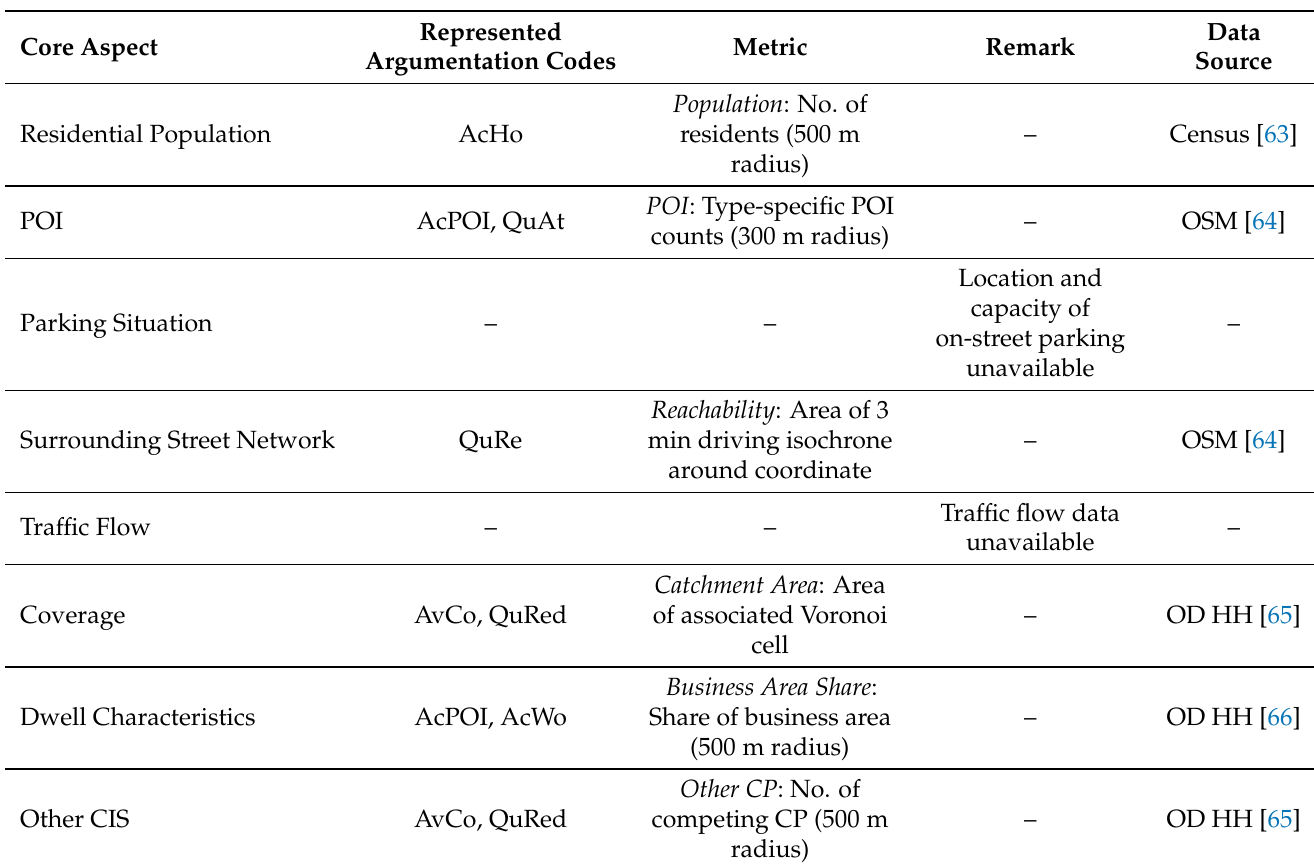
Table 6. Derived metrics for the Hamburg case study. OSM: Open Street Maps; OSRM: Open Source Routing Machine; OD HH: OpenData